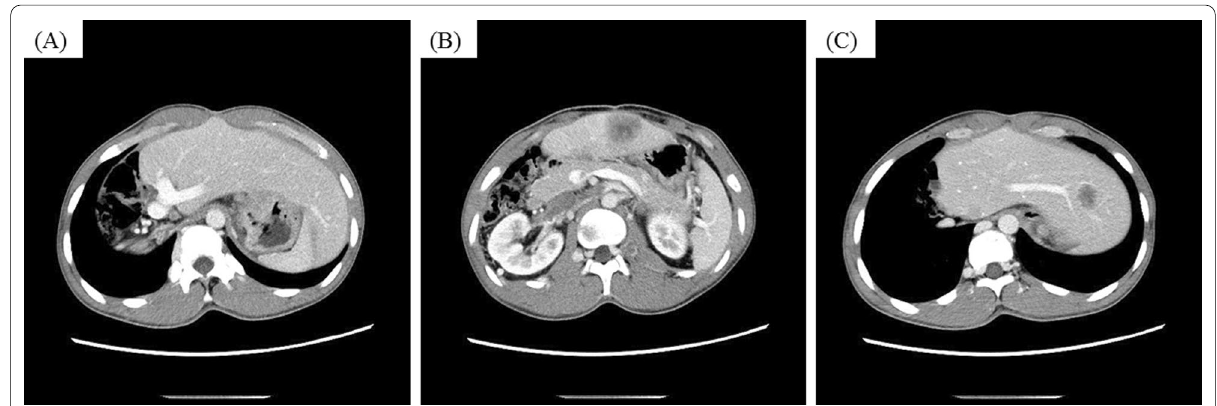
Fig. 3 A Contrast-enhanced computed tomography revealing tumor invasion beyond the serosal layer. B , C Multiple metastatic lesions in the transplanted